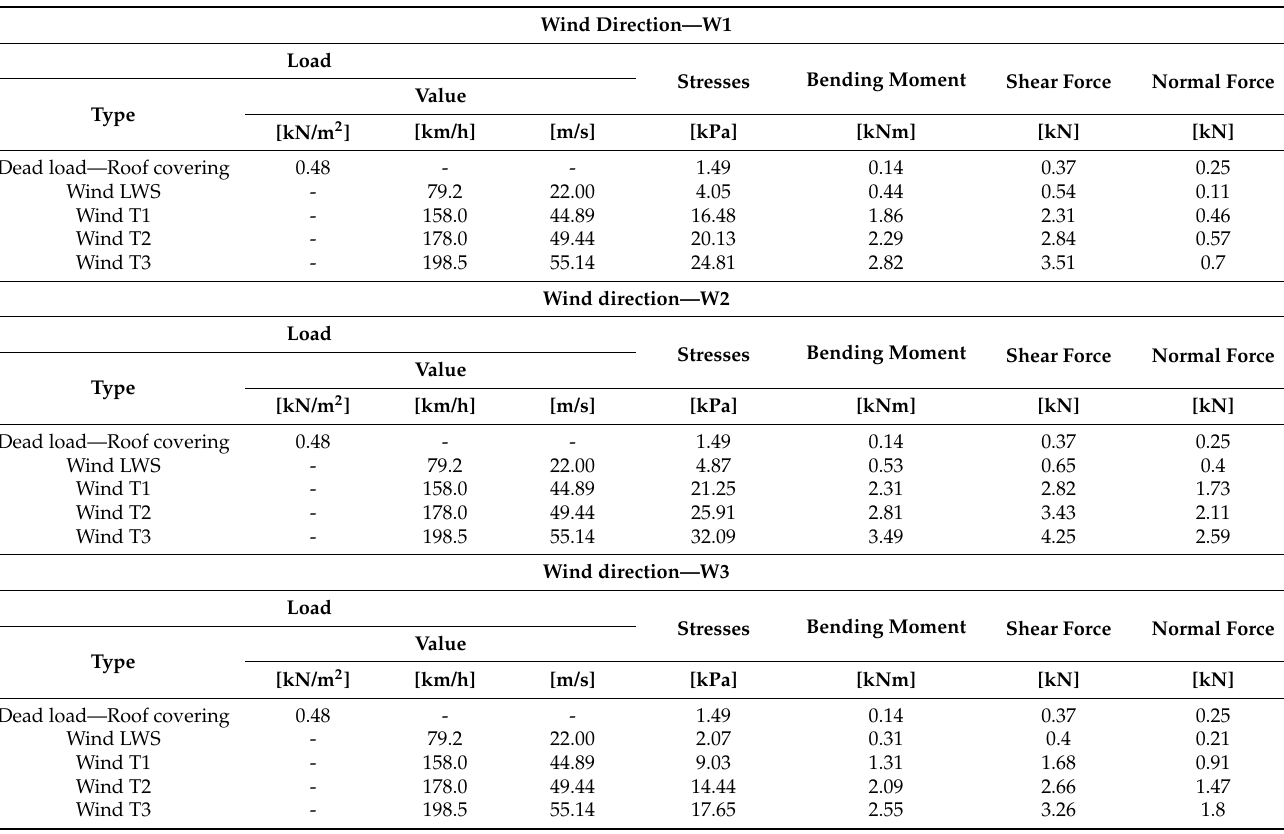
Table 5. Tables presenting the list of maximum internal forces (stresses, bending moments, shear force, normal force) and deflection at different wind directions and speeds.